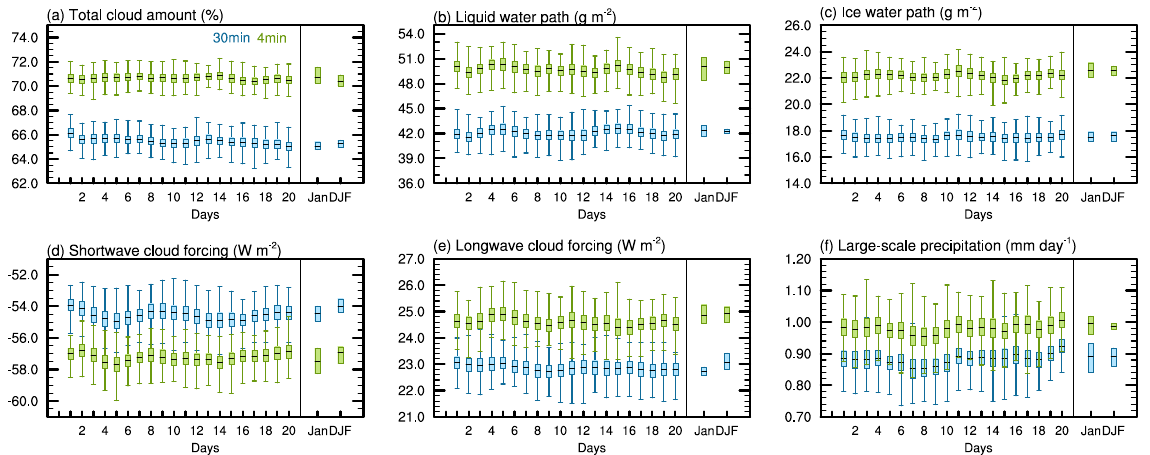
Figure 4. Global mean values of some cloud-related variables from the 50-member ensembles and from the 5-year climate simulations. Blue and green indicate simulations performed with 30 and 4min time steps, respectively. The left part of each panel shows the daily mean global averages in the first 20 days of the ensemble simulations. The lower and upper ends of the whiskers denote the 10th and 90th percentiles. The hinges in the middle indicate ensemble mean. The filled boxes show the 95% confidence interval of the mean. In the right part of each panel, the January and DJF averages of the 5-year climate simulations are shown. The bottom and top of each box correspond to the minimum and maximum January or DJF averages in the simulation period. Hinges in the middle indicate the 5yr average. Further details are explained in Sect. 3.2.